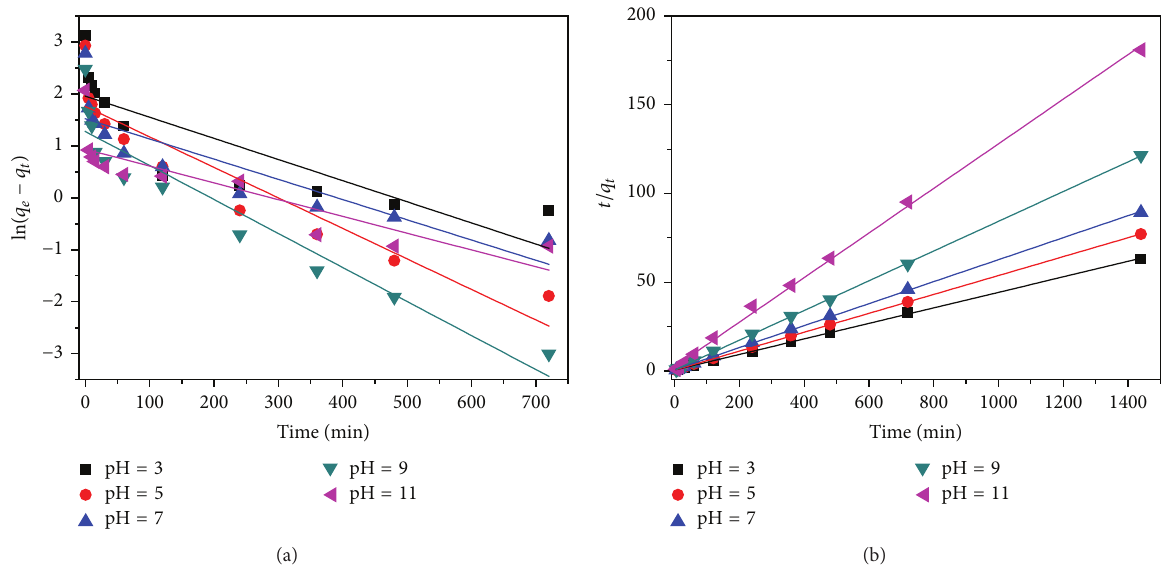
Figure 6: Linear adsorption kinetics for pseudo-first-order and pseudo-second-order simulation of ORII adsorption onto the CTAB- modified cornstalk biochar.